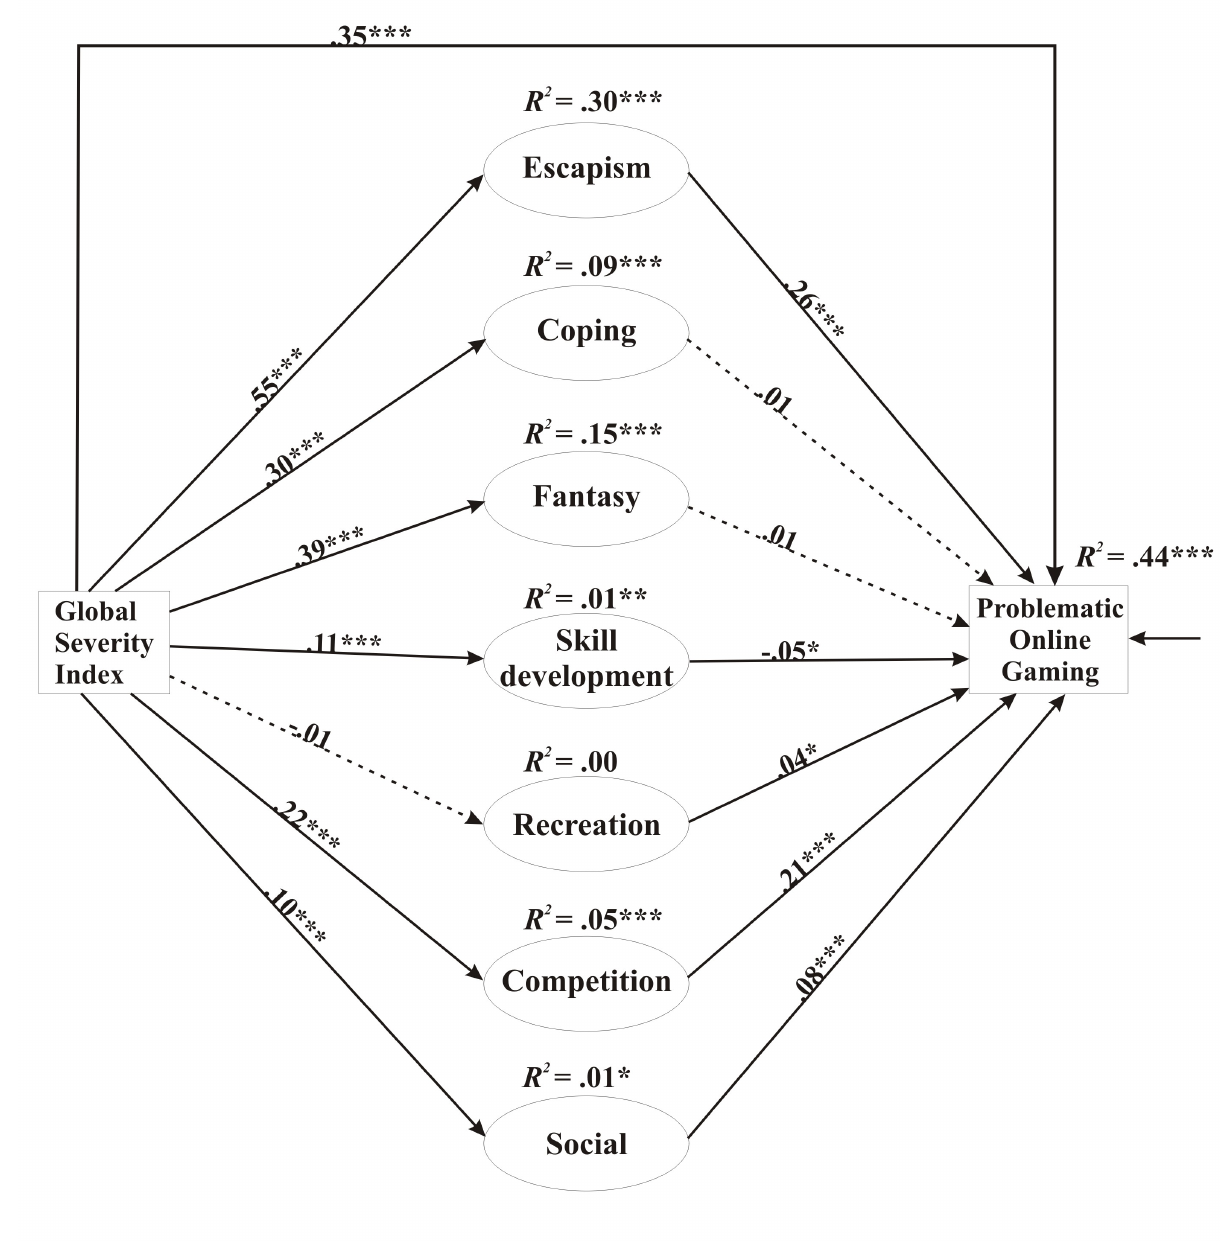
Figure 1. The overall mediation model with standardized path coefficients and the explained variance of the endogen variables ( R 2 ) (N=3186). All 7 mediator variables are latent variables. For clarity, indicator variables associated with them have not been depicted in this figure but were published in an earlier paper [8]. Also for clarity, the covariances between the errors of all mediator variables have not been depicted in the figure. Simple arrows: significant path coefficients, dotted arrows: nonsignificant path coefficients. * P <.05; ** P <.01; *** P